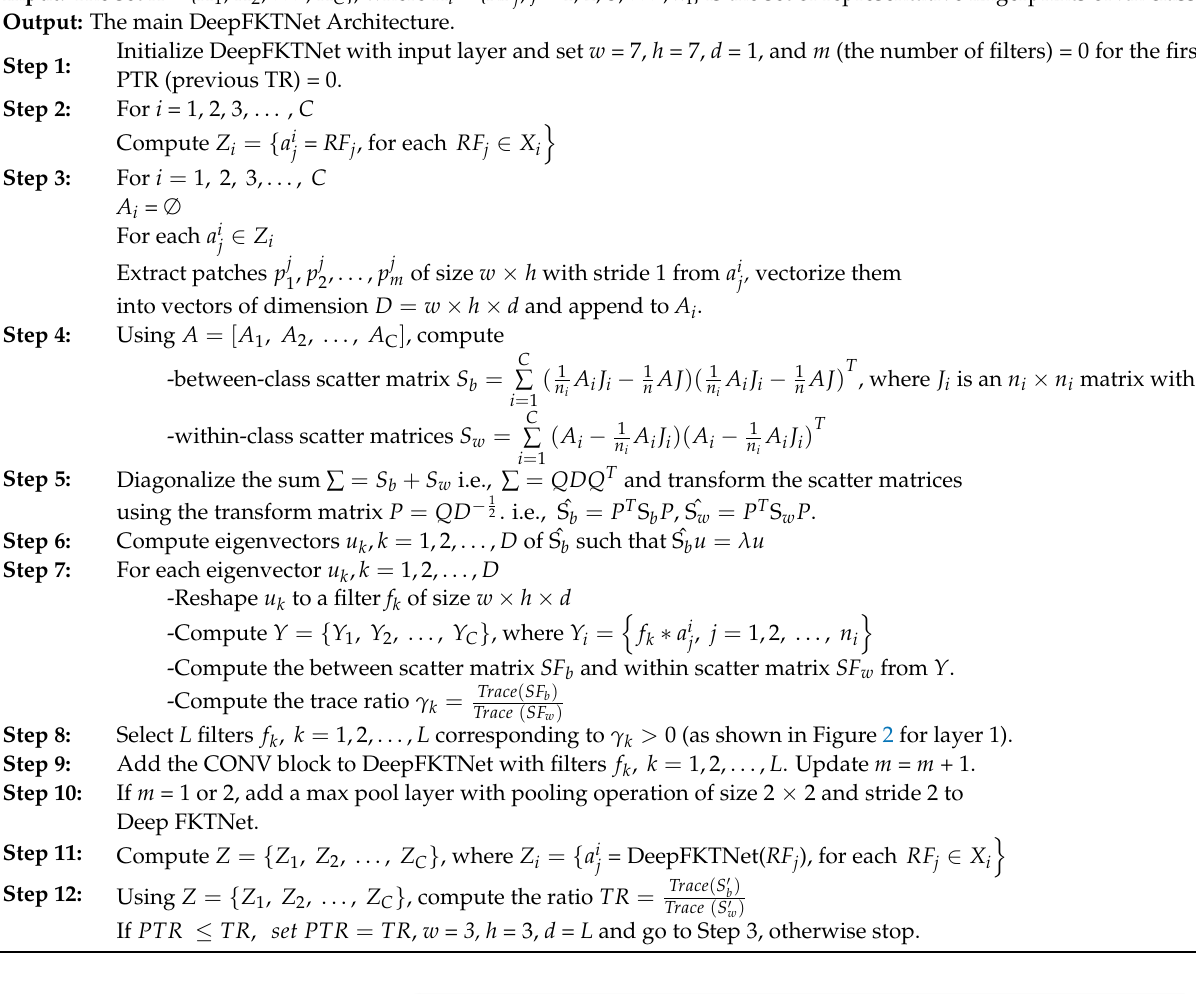
Algorithm 1: Design of the main DeepFKTNet Architecture